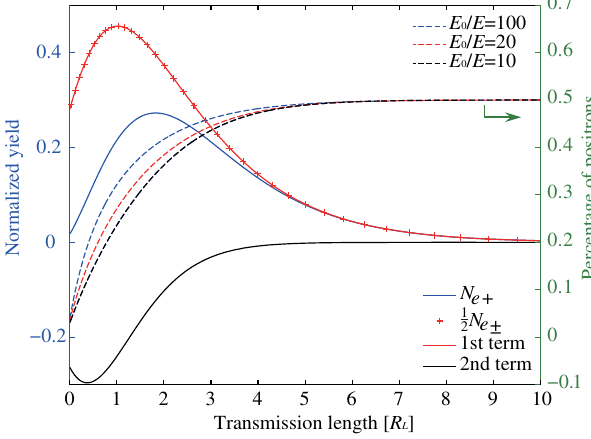
E ; E; t Þ obtained by e þ ð 0